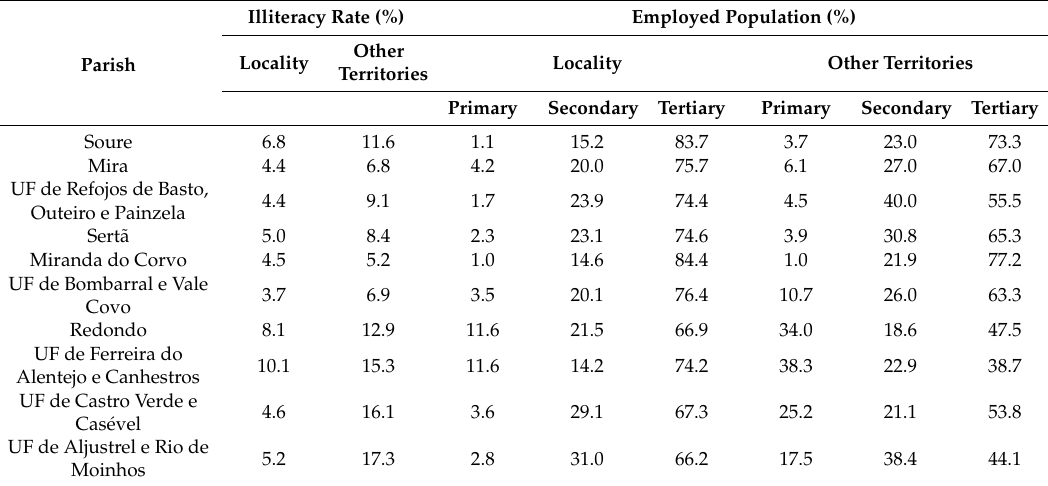
Table 8. Illiteracy rate (%) and employed population (%) in localities with the municipal headquarters, and other territories belonging to APU (TIPAU) and Code 3 (DEGURBA)